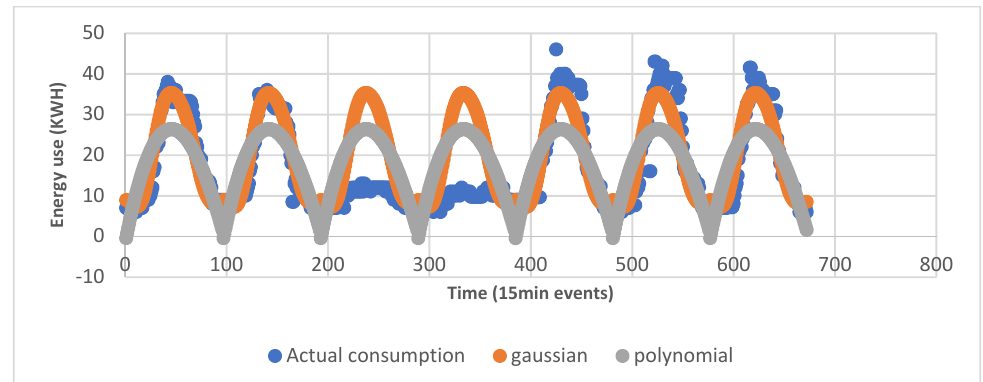
Figure 7. A comparison of SVR kernel predictions.